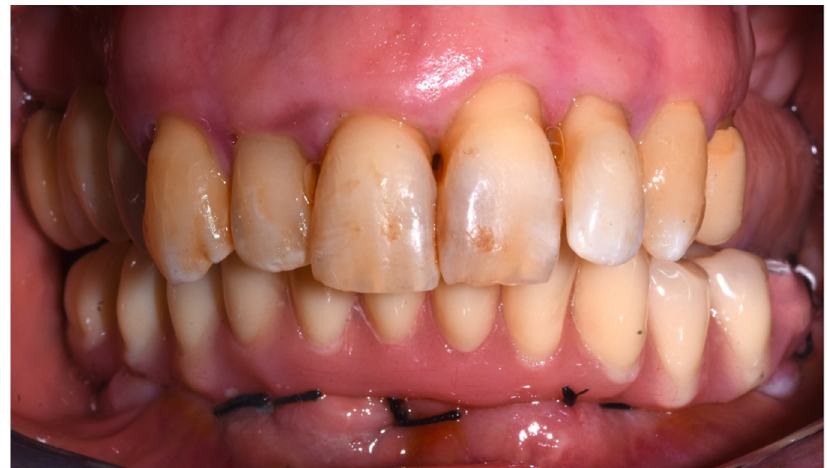
Figure 8. Provisional full-arch prosthesis.